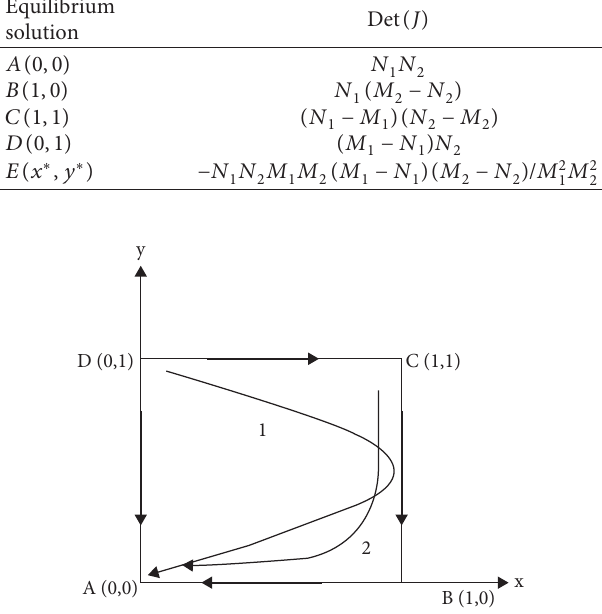
Table 5: Stability analysis of equilibrium points when M